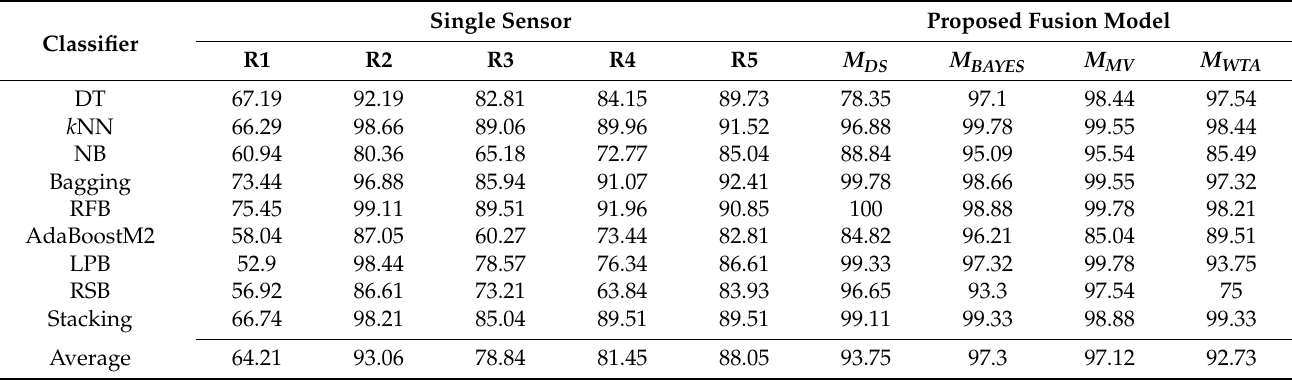
Table 5. Mean accuracy of independent sensor and fusion model with ICA (in %).